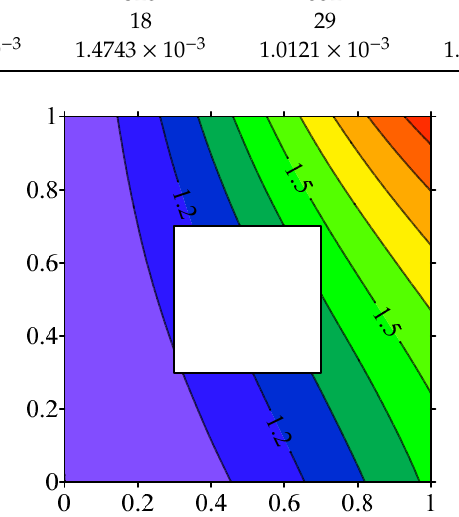
Figure 12. Distribution of the numerical solution in case 5.